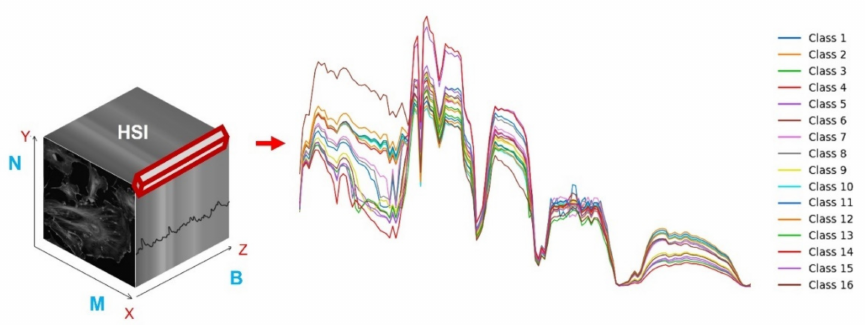
Figure 1. A representation of the hyperspectral image of size M × N × B, with the corresponding spectral information along a large number B of narrow continuous wavelengths (left); an illustration of different spectral information (along the B dimension) for a similarly looking spatial geometry point/patch in the N × M plane from 16 different object classes